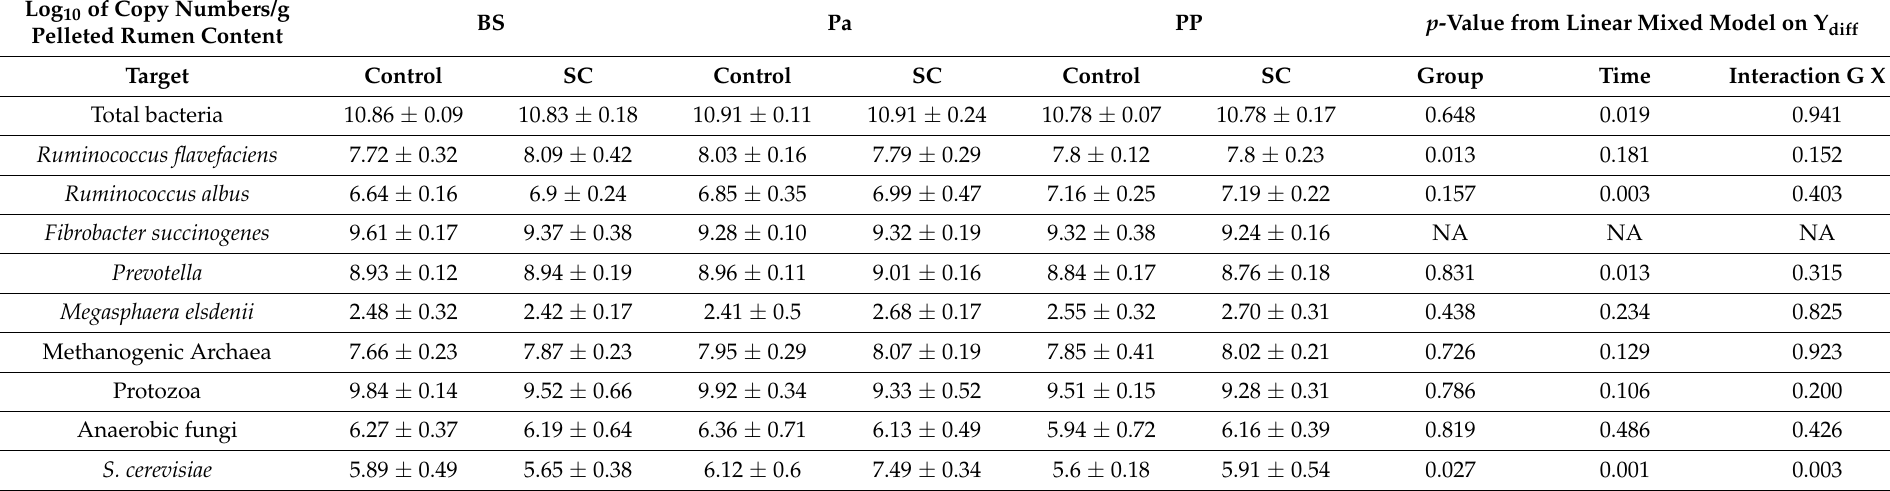
Table 2. Q-PCR microbial quantification results for the targeted microbial groups or species in the ruminal samples ( n = 6 per group) and the p -values associated with the statistical analysis performed on Y diff with a linear mixed model. BS = before supplementation of SC, Pa = close to parturition, PP = 2 weeks postpartum. NA indicates that the linear mixed model was not applied to these